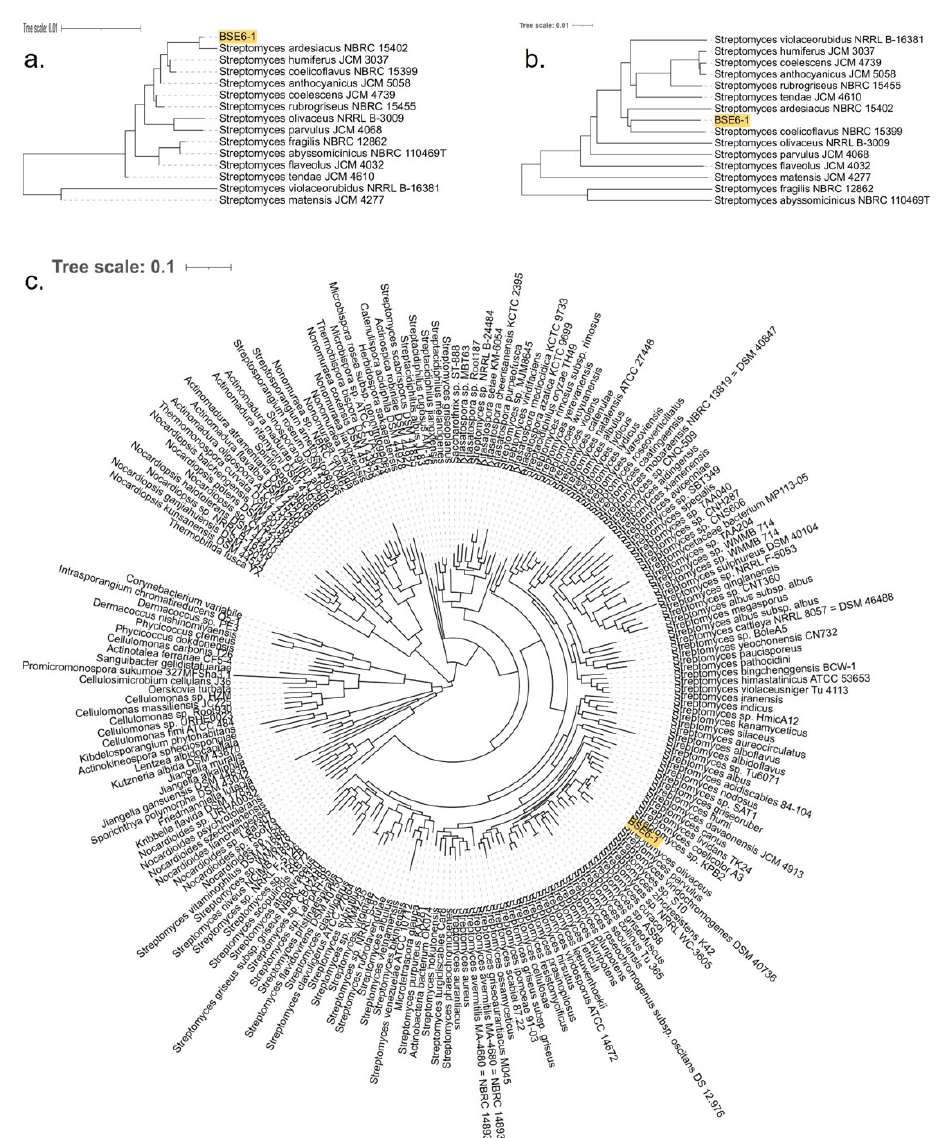
Figure 4. GBDP tree with 100 bootstraps for ( a ) 16S rRNA genes and ( b ) genomes of strain BSE6.1 along with 14 type strains with highest dDDH (d4) similarity. ( c ) Species tree constructed using 49 core/conservative COGs of strain BSE6.1 and 200 related/homologous genomes with at least 90% 16S nucleotide identity and ~80% whole-genome aligned fraction identity. Table 3. MLST profile of Streptomyces sp. strain BSE6.1 genome. Locus Identity